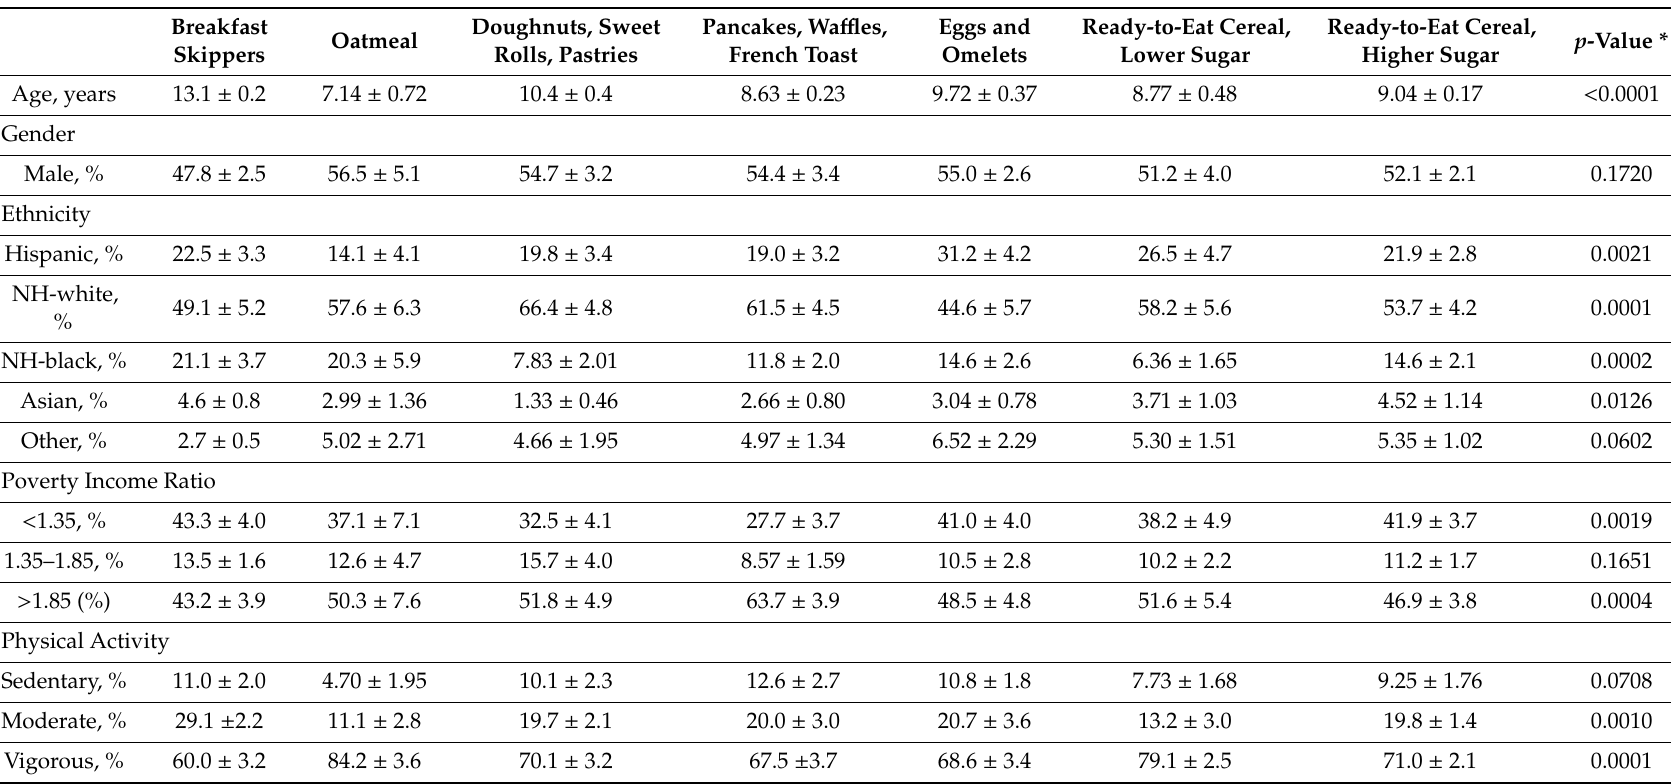
Table 1. Demographic profiles of child consumers of di ff erent breakfasts and breakfast skippers, ages 2–18 years, National Health and Nutrition Examination Survey (NHANES)